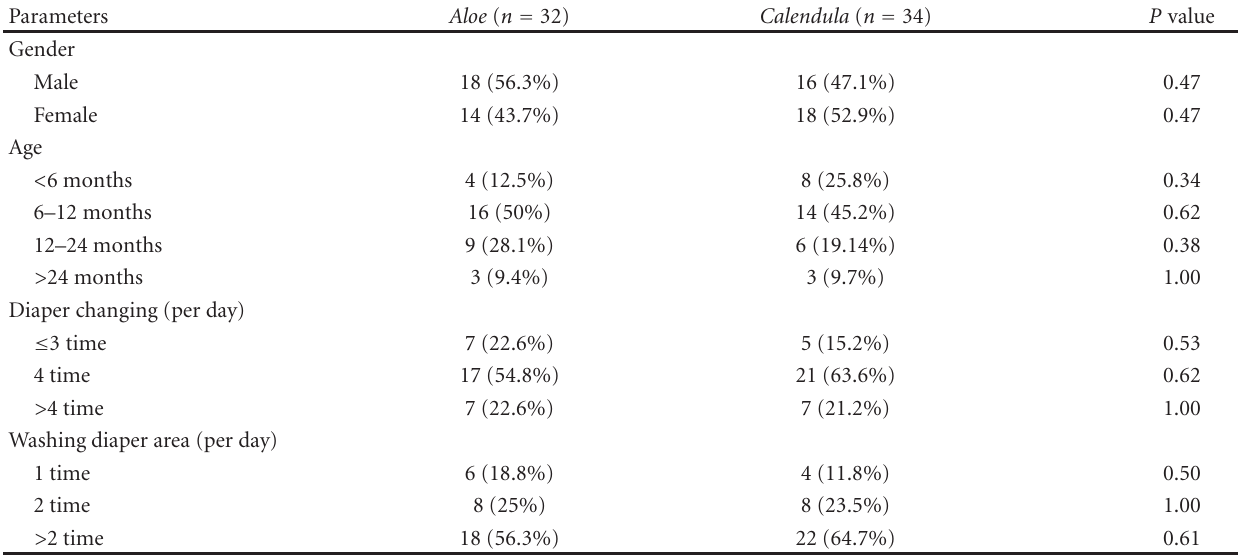
Table 1: Demographic characteristics of study groups.